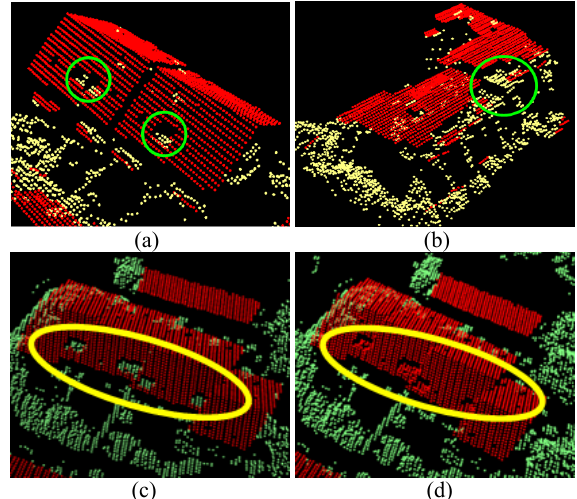
Figure 3: (a) and (b) segmentation results (red: long segments, yellow: short segments); (c) and (d) building extraction results before and after the region growing based quality improvement (red: buildings, green: vegetation).